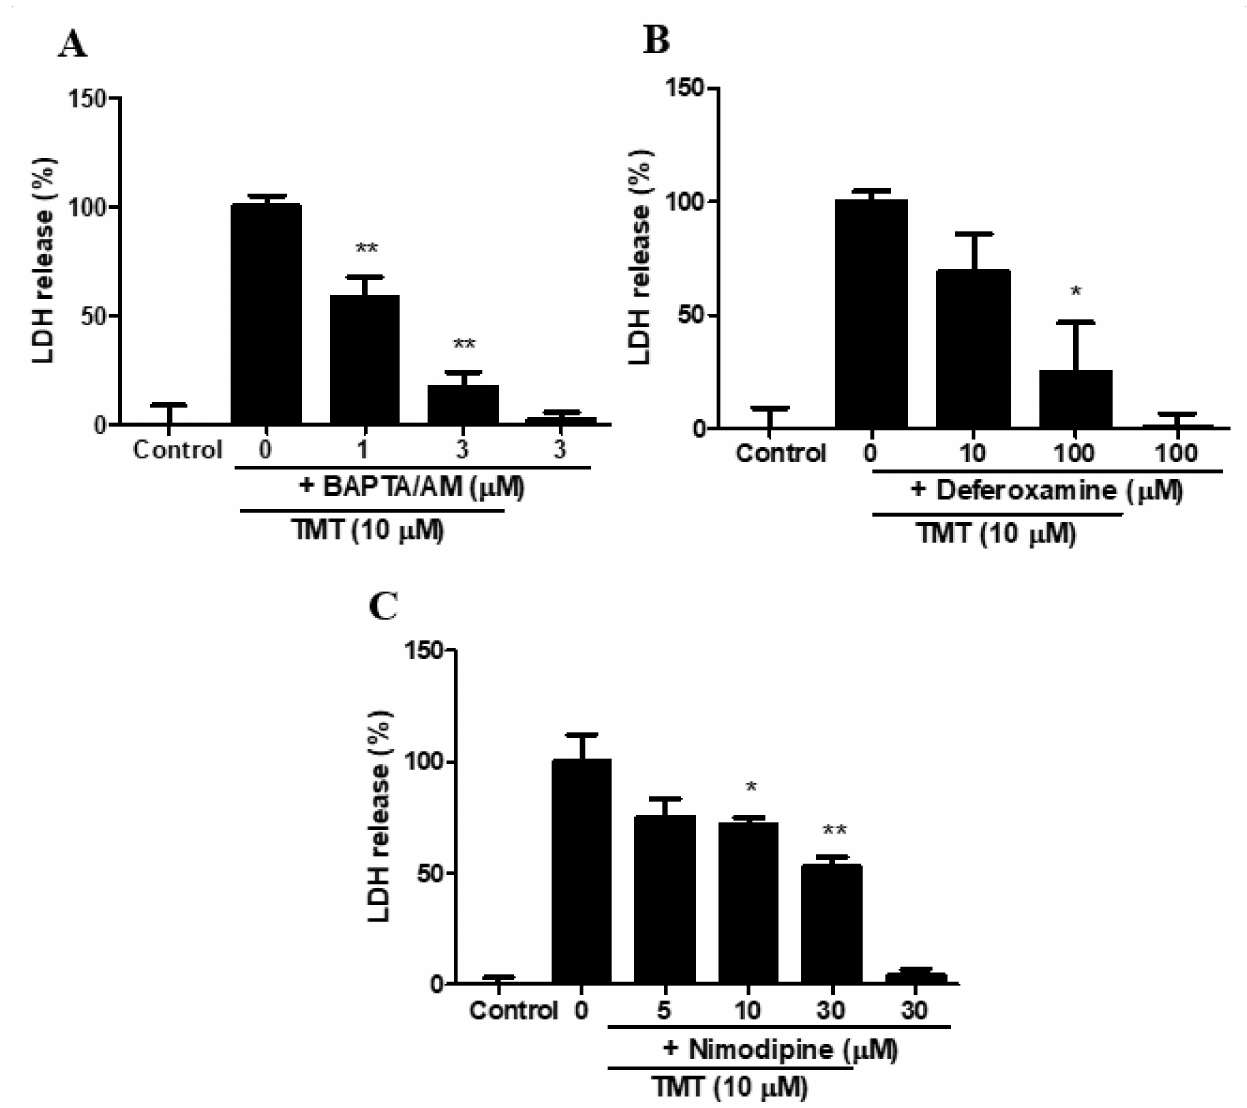
Figure 10. Protective effects of BAPTA/AM ( A ), deferoxamine ( B ), and nimodipine ( C ), on TMT-induced neurotoxicity in SH-SY5Y cells. Cytotoxicity was evaluated using a lactate dehydrogenase (LDH) release assay. * p < 0.05, ** p < 0.01 compared to 10 µ M TMT-treated group ( n = 4). Experiments were performed at least three times, with similar